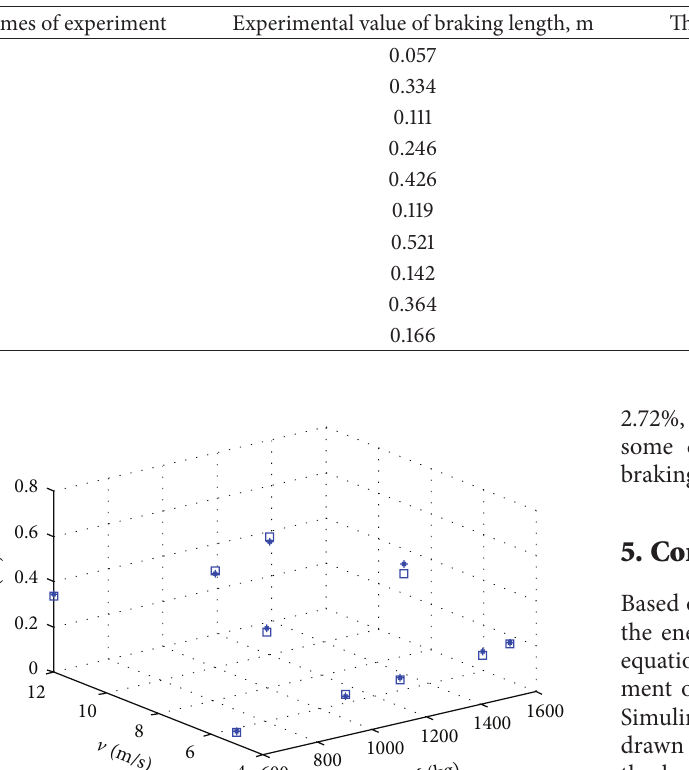
Table 10: Experiment data processing of tramcar braking distance.